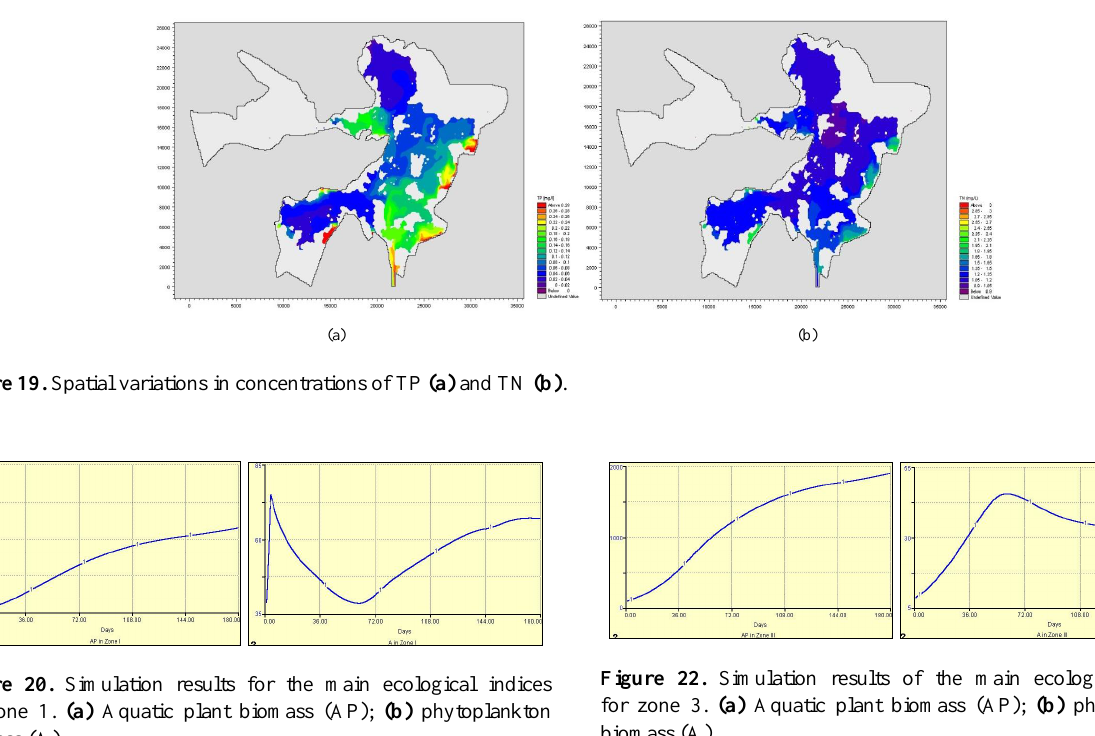
Fig. 18. The changes of concentrations of TP (a) and TN (b) at Site 8